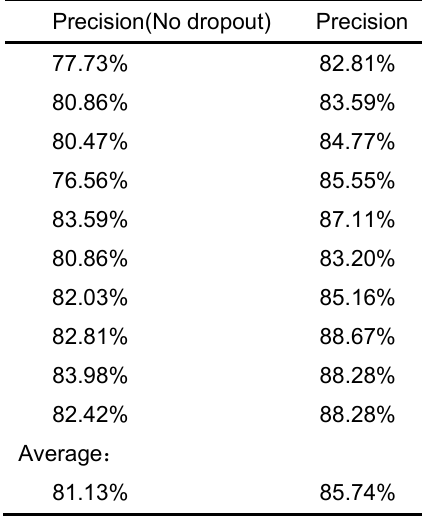
Table 4 Comparison of Precision (no dropout) and Precision (with dropout)